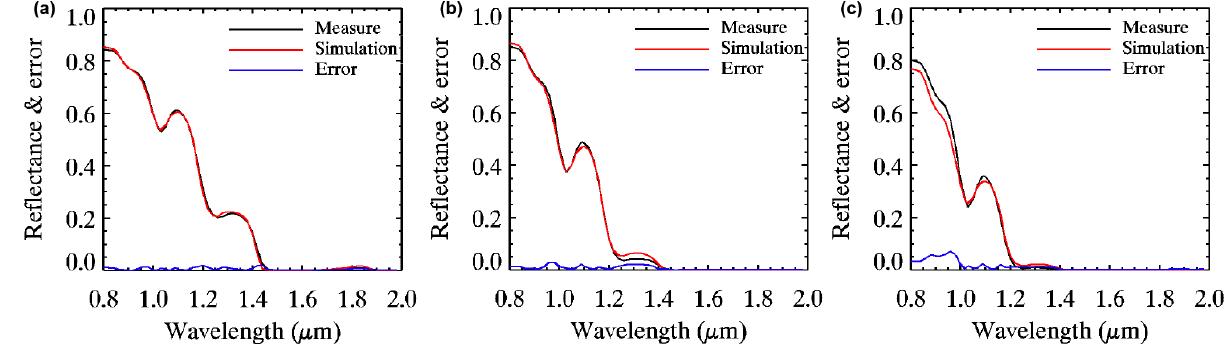
Figure 10. Reflectance factor spectra for the measure and the simulation at the maximum likelihood, and for the geometry for which maximum likelihood was highest, for each sample: at incidence 40 ◦ , emergence 10 ◦ and azimuth 140 ◦ for sample 1 (thickness: 1 . 42mm) (a) ; at incidence 40 ◦ , emergence 20 ◦ and azimuth 45 ◦ for sample 2 (thickness: 7 . 45mm) (b) ; and at incidence 60 ◦ and emergence 0 ◦ for sample 3 (thickness: 12 . 51mm) (c) . The thicknesses indicated were measured before putting the sample into the spectro-radiogoniometer, and the errors are given at 2 σ . The absolute differences are shown in blue on each graph.